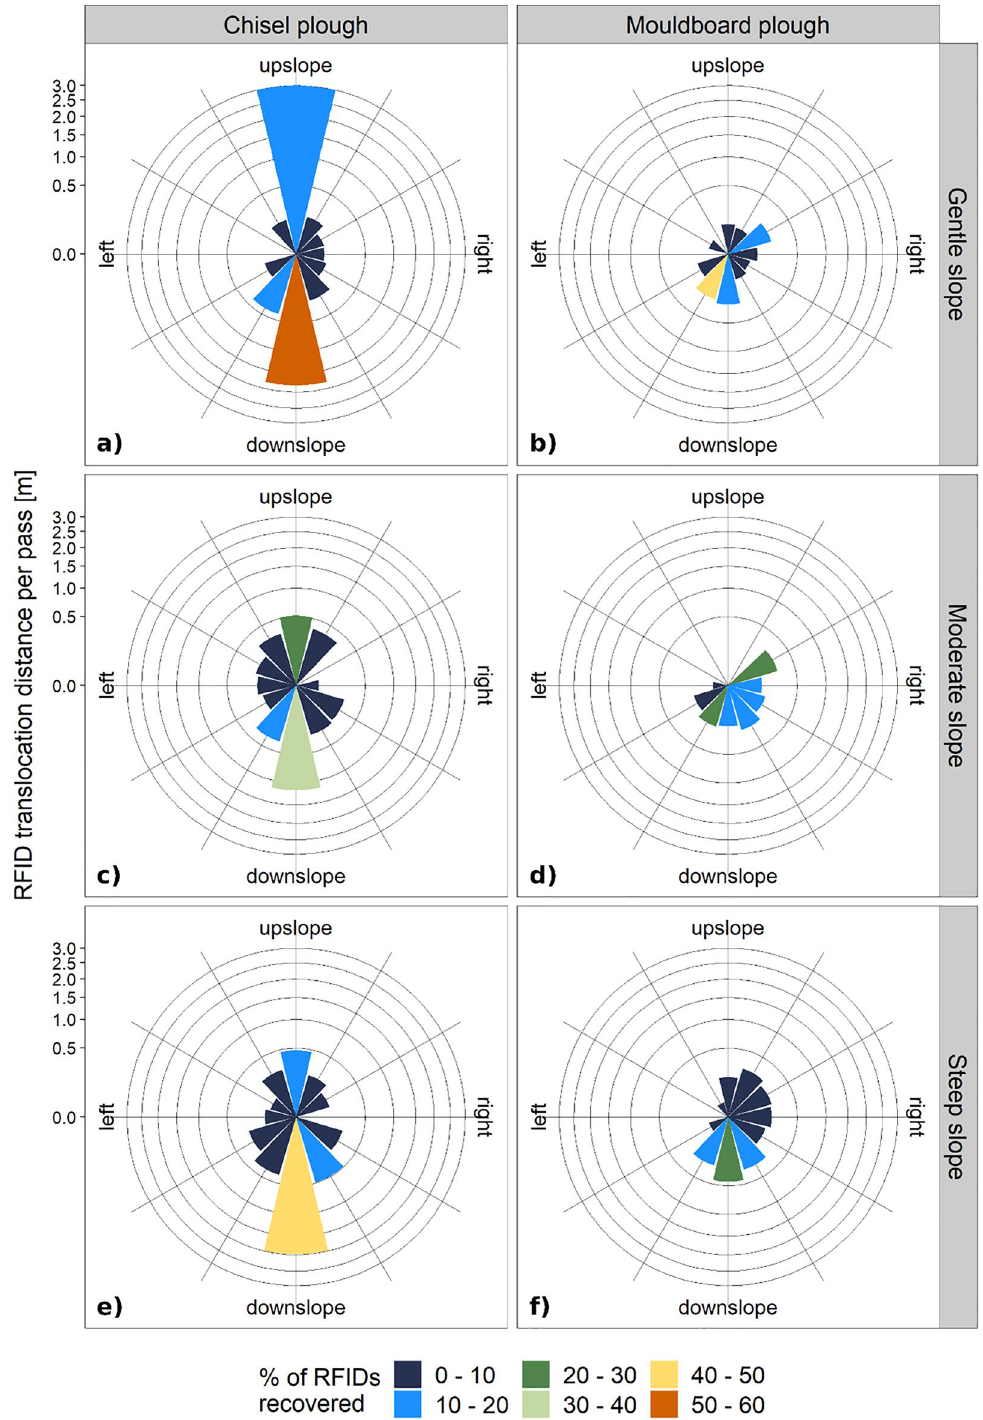
Figure 5. Direction and net translocation distance of the RFID translocation per pass [m] for the two tillage implements chisel and mouldboard plough (in columns) and the three experimental sites ( a , b ) gentle, ( c , d ) moderate, and ( e , f ) steep slope (in rows). Colours indicate the percentage of RFIDs from all inserted RFIDs per experimental plot ( a – f ) that were translocated in each direction (360° divided in 12 segments of 30° each). Direction of translocation is related to the field geometry. Please note that the y-axes is square root transformed, i.e. unequally sized space between axis breaks for a better comparison of chisel and mouldboard plough